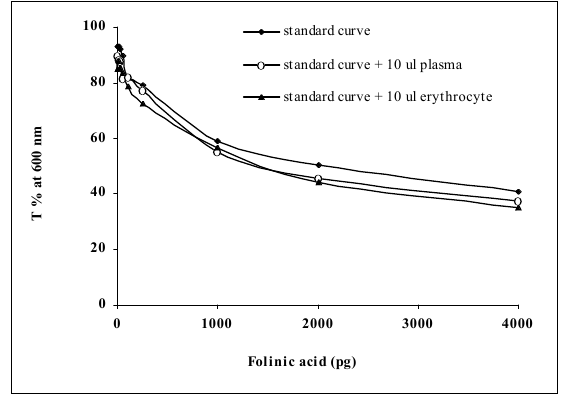
Figure 3. Standard curve with and without biological material (amounts of folinic acid were put into assay tubes of 3.9 ml).